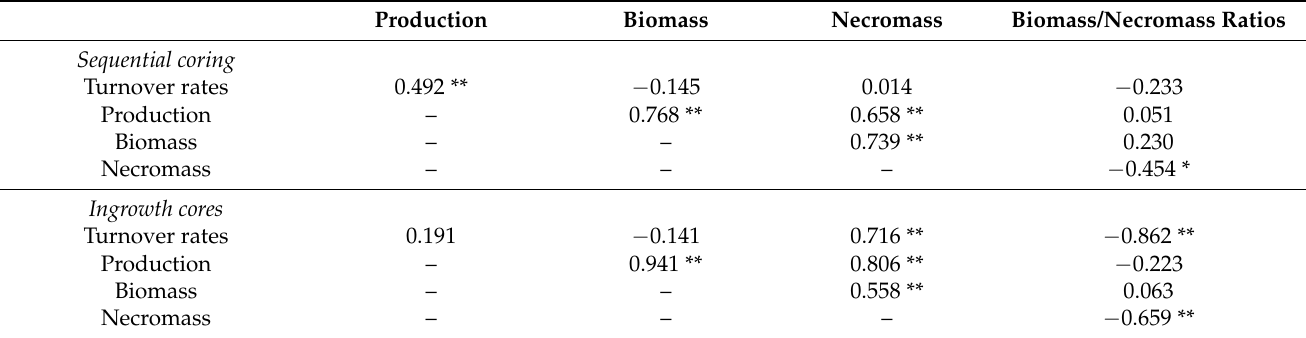
Table 5. Relationships between fine root turnover and production, biomass, and